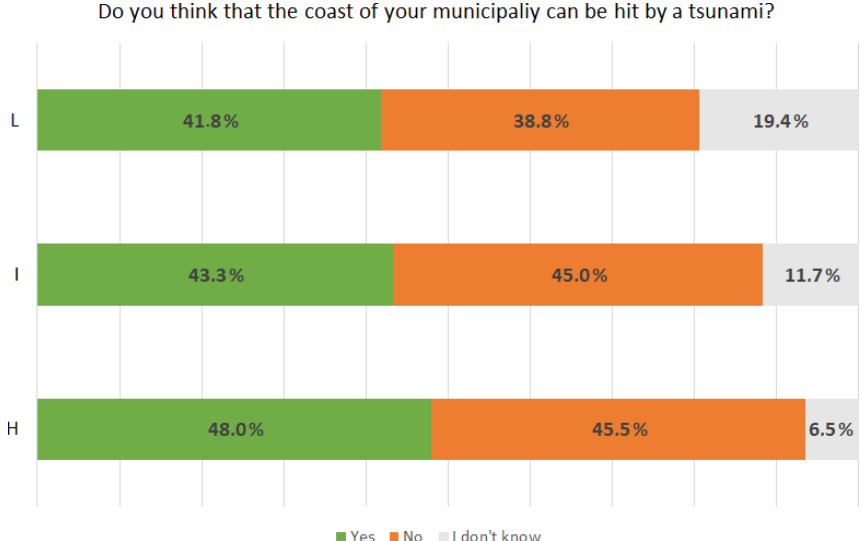
Figure 6. Tsunami risk perception by education (L: low level of education or no instruction; I: intermediate, secondary school and high school; H: graduate and post-graduate).